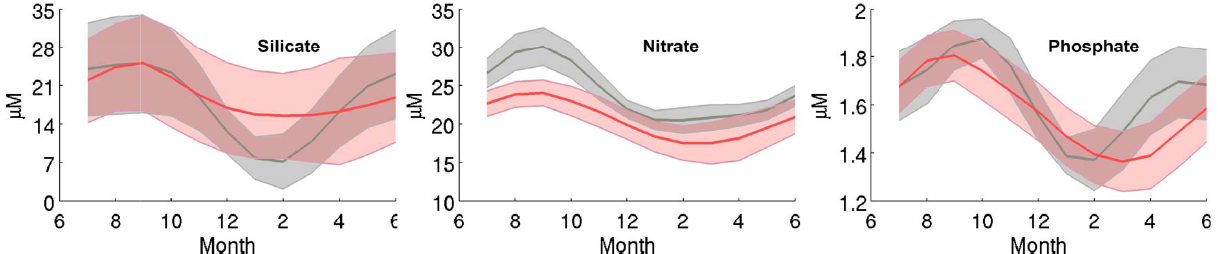
Fig. 5. Annual cycles of surface (0–30m) silicate (A) , nitrate (B) and phosphate (C) concentrations averaged over the South Georgia domain defined between 45–32 ◦ W and 56–50 ◦ S (shown in Fig. 7a) from the CARS2009 climatology (black lines) and from model outputs from the last modelling year of the SEDDUST scenario (red line). Shaded areas indicate the standard deviation of the